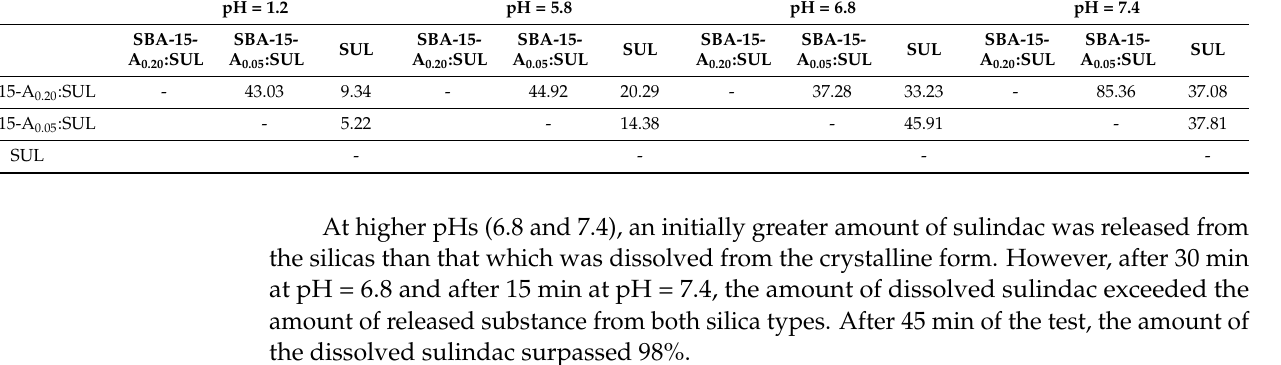
Table 2. Comparison of the similarity coefficient f 2 between crystalline SUL and mesoporous silica. Hydrochloric Acidic Medium pH = 1.2